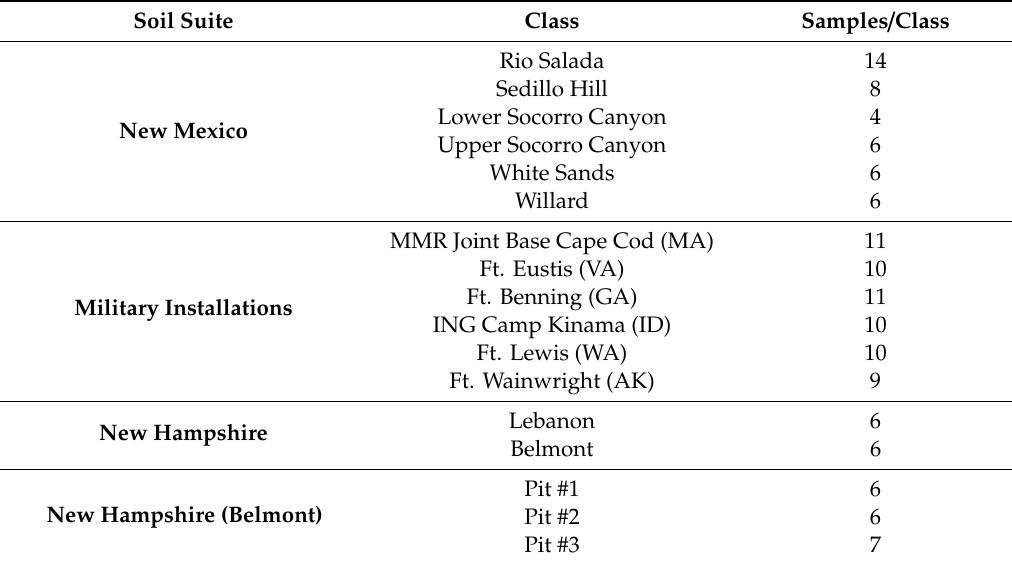
Figure 2. Example of the XRFS, RS, and LIBS spectra used in this study for data fusion, in this case for the White Sands, NM soil. The XRFS spectrum ( A ) shows principally the presence of Ca, Sr, S, and Fe; the RS spectrum ( B ) shows the presence of documented bands for the vibrational modes of gypsum, CaSO 4 · 2H 2 O [58]; and the LIBS broadband spectrum ( C ) showing mainly the presence of Ca and Sr, together with the minor levels of Si and Na. Note the presence of broad bands in the LIBS spectrum corresponding to the molecular bands of CaO, a species that is formed when O from the sample and the ambient atmosphere combines with the Ca in the soil. Table 1. Definition of the soil classification schemas and number of samples per